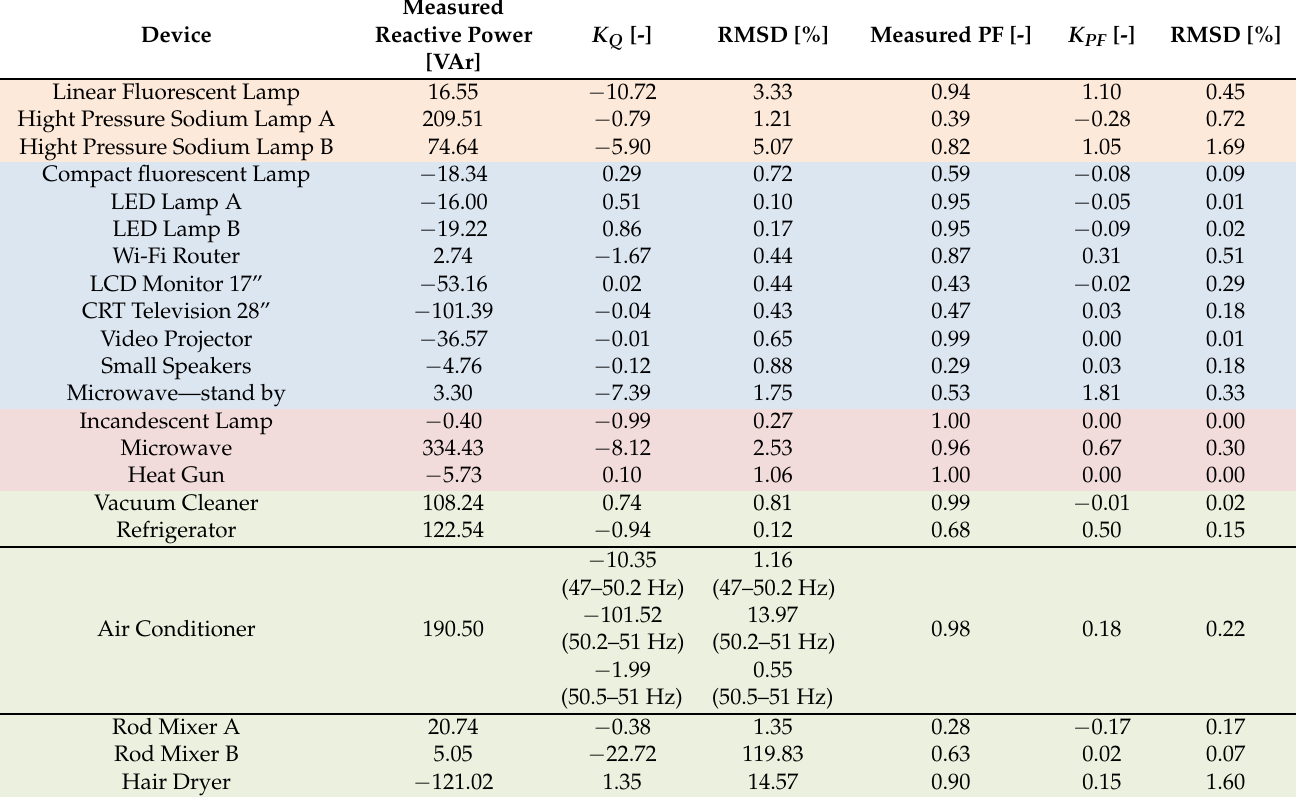
Table 5. Results of analyzed single-phase home